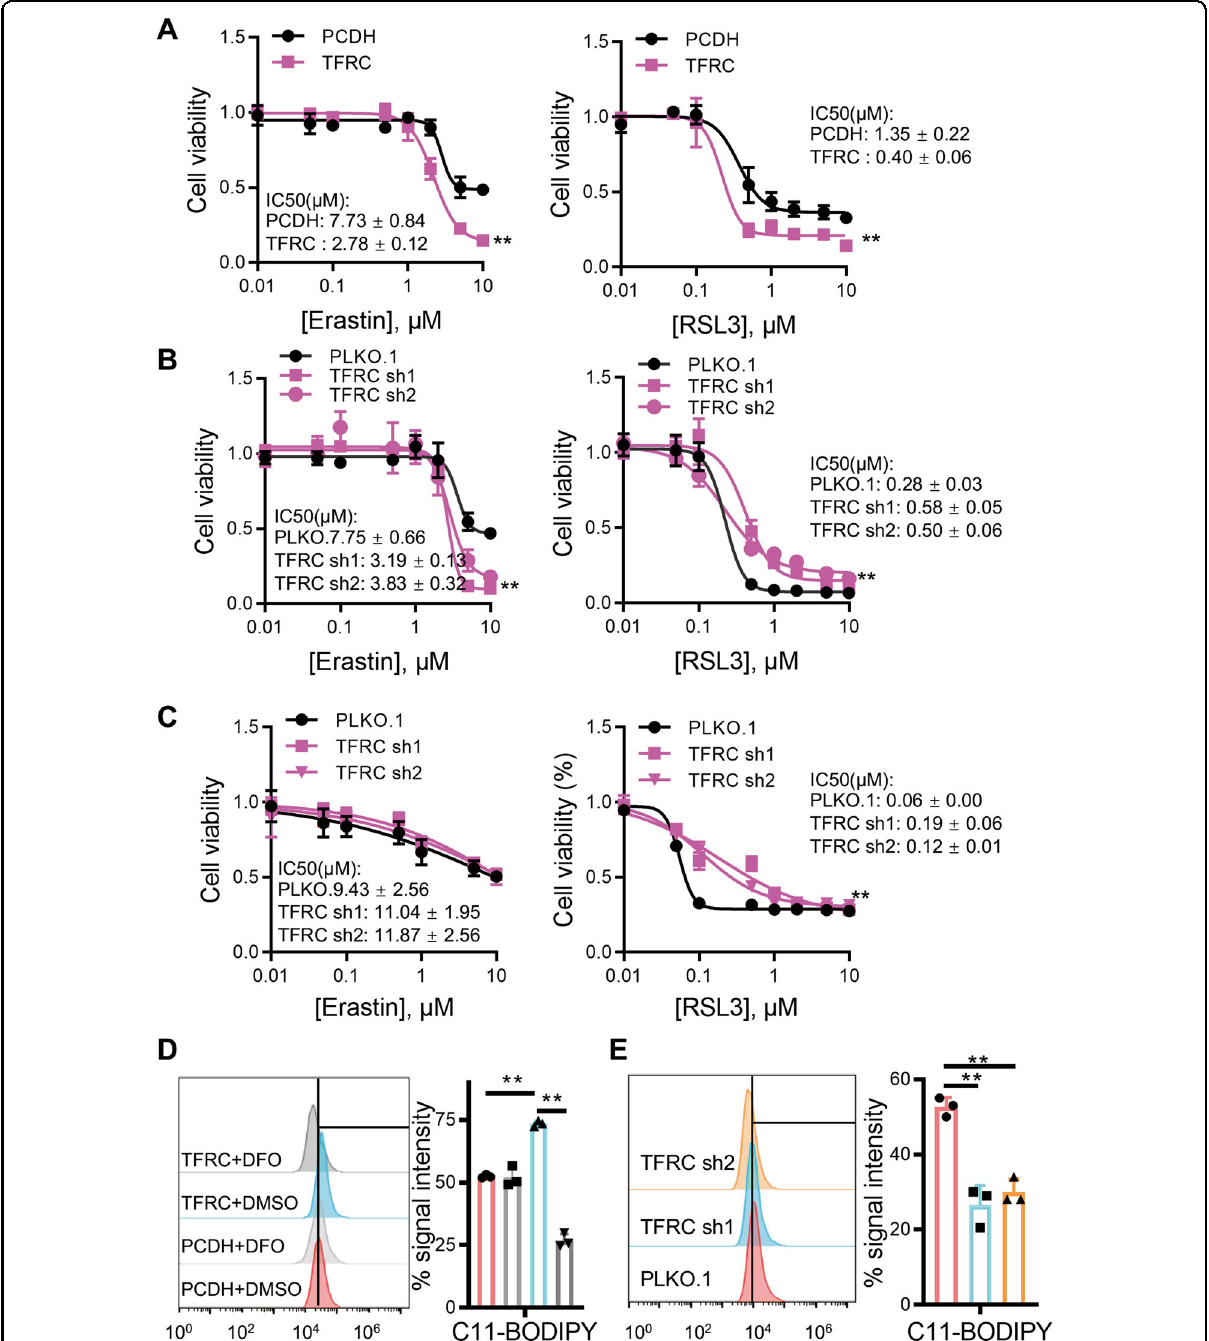
Fig. 5 TFRC mediates MYCN – induced, GPX4-dependent ferroptosis. A Cell viability of SHEP cells with or without TFRC overexpression incubated with Erastin (left) or RSL3 (right). Cell viabilities of SHEP ( B ) or SK-N-BE2 ( C ) cells with or without TFRC depletion incubated with Erastin (left) or RSL3 (right). Amounts of cellular lipid peroxides measured by C11-BODIPY in SHEP ( D ) or SK-N-BE2 ( E ) cells with or without TFRC . Data are presented as mean ± SD of three replicates. Two-tailed unpaired t -tests were performed to calculate p v alues. ** p <